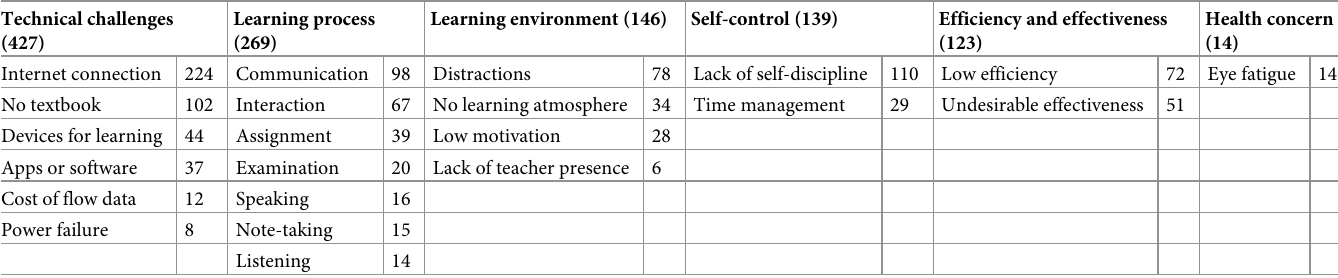
Table 6. Categories of challenges reported by students (codes and frequencies).